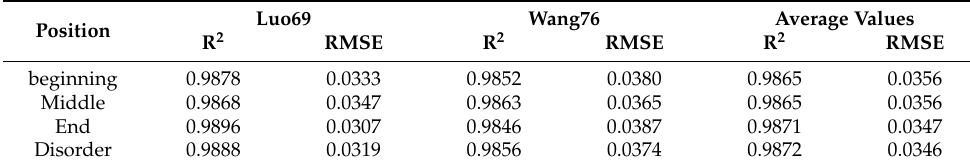
Table 4. Selection experiments of logging parameter sequence.